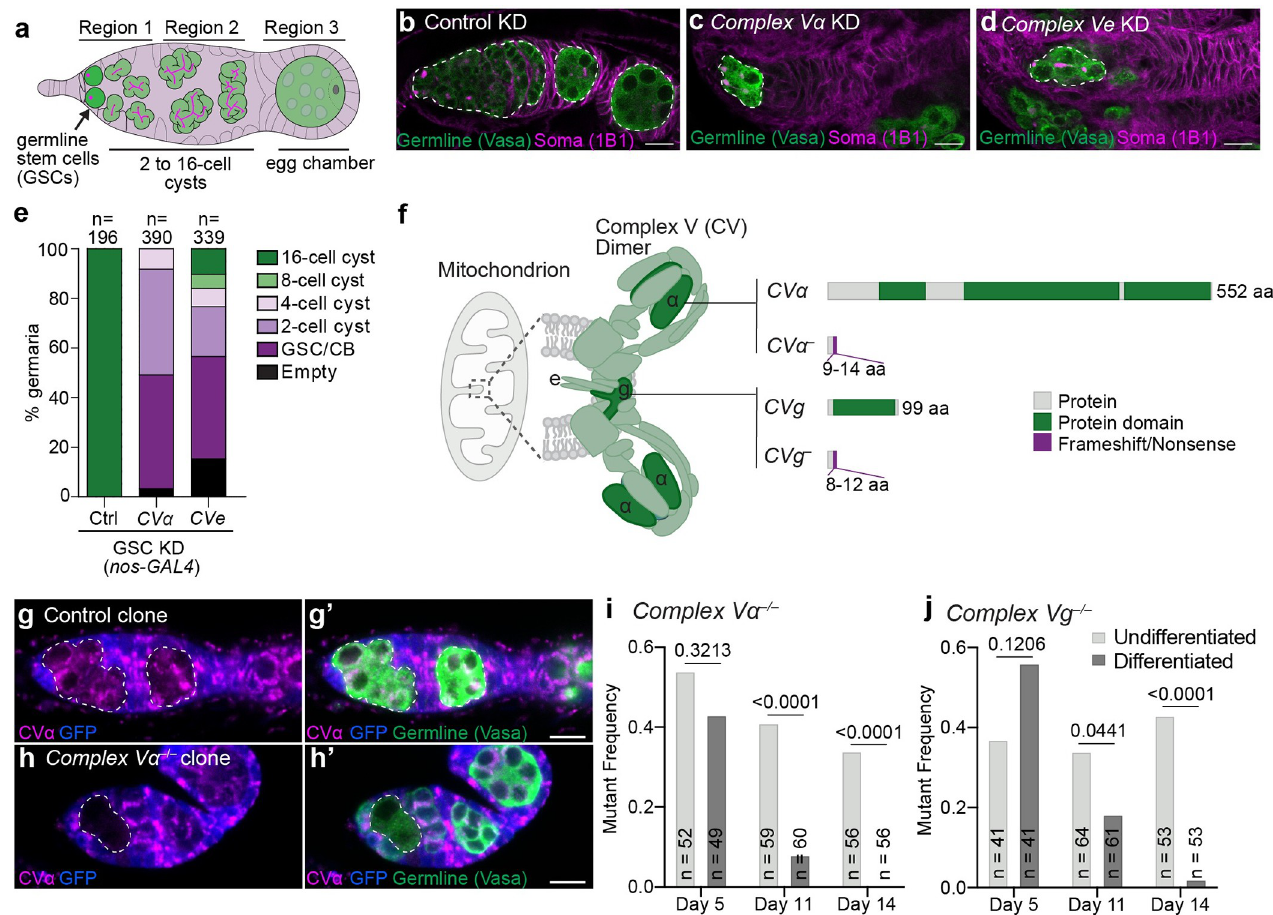
Fig 1. Complex V is essential for germline stem cell differentiation. (a) Drosophila germarium. GSCs at the anterior tip of germaria asymmetrically divide and differentiate. The differentiating cell undergoes four rounds of mitosis with incomplete cytokinesis to generate a 16-cell interconnected cysts. The 16-cell cyst buds off as an egg chamber to further mature into an egg. (b-d) Representative images of 1-day old Control ( mCherry ) (b) , CV α (c) , and CVe (d) KD germaria driven by nos-GAL4 . White-dashed lines mark the germline. (e) Quantification of the latest differentiation stage in germaria of indicated genotypes. RNAi were driven by nos-GAL4 . Number of germaria scored is indicated above each bar. (f) Complex V dimer at the tip of mitochondrial cristae. CV α forms one of the main catalytic components of the complex. Subunits g and e are required for dimerization. Putative null alleles in α and g were generated. (g, h) Representative images of Control (g) and CV α (h) mosaic germaria 14-days after clone induction. Mutant GFP-negative clones are marked with the white- dashed lines. (i, j) Frequency of CV α (i) and CVg (j) mutant clones 5-, 11- or 14-days after clone induction. Undifferentiated: germline cells in region 1 including GSC, cystoblasts, 2-, 4- and 8-cell cysts. Differentiated: germline cells in region 2 containing 16-cell cysts. Number of germaria observed are given inside the bars. P-values were calculated using Fisher’s exact test. For all images scale bars represent 10 μ m. For exact genotypes see S2